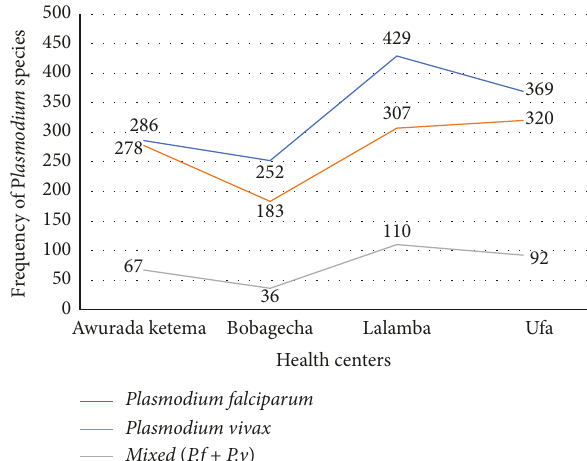
Figure 2: Plasmodium species distribution by health center over the past five years